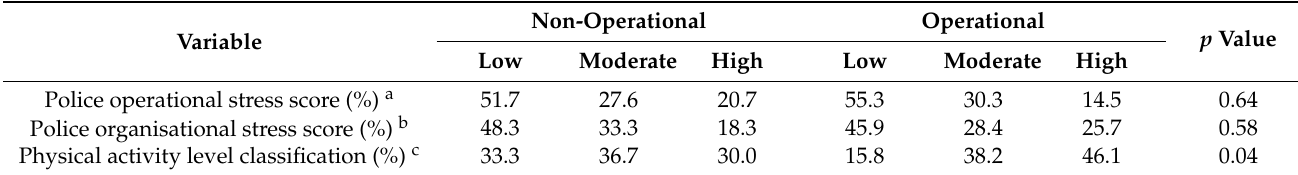
Table 3. Associations of job type with stress and physical activity levels.